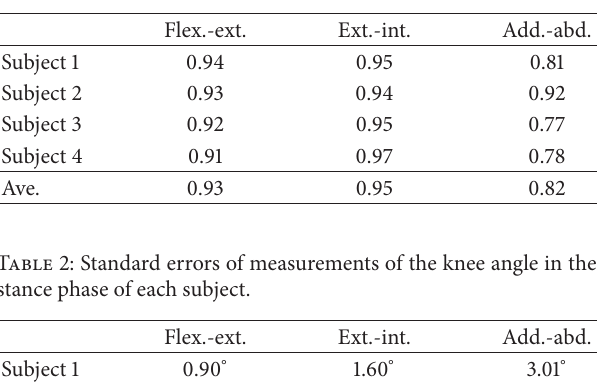
Table 1: Coefficients of multiple correlations of the knee angles in the stance phase of each subject.